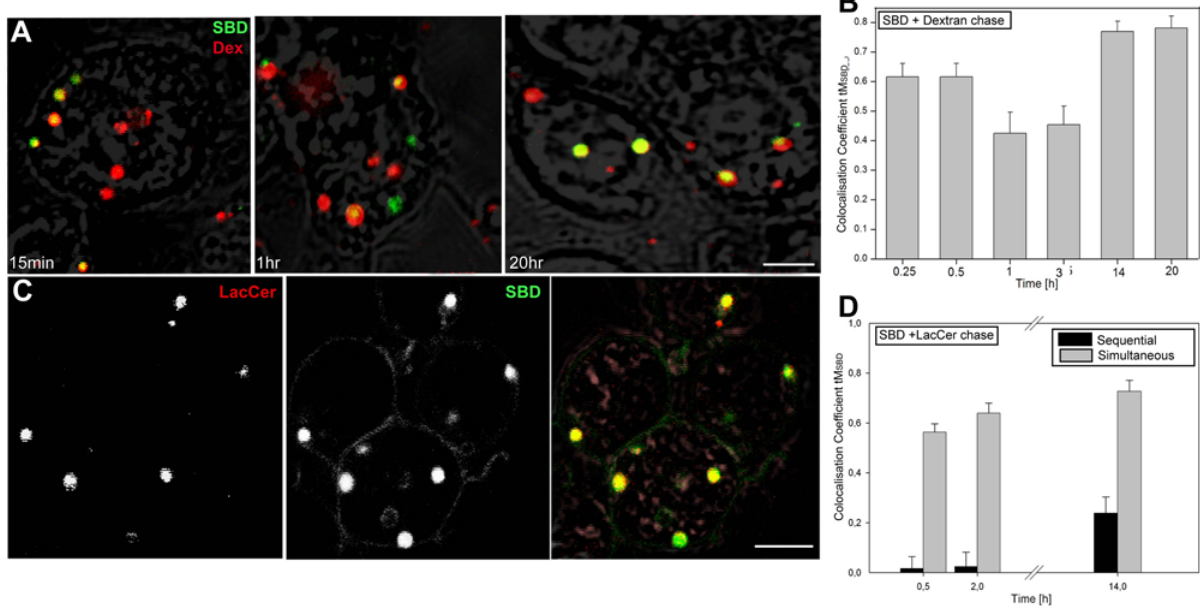
Figure 8. SBD-OG traffics similarly to pulsed Dextran-Alexa670 and lactosyl-ceramide when both labels are present simultaneously at the plasma membrane. A, B. SBD-OG follows a similar pathway to Dextran-Alexa670 (shown after 15 9 , 1 h, and 20 h), but appears to diverge transiently in post-sorting late endosomes between , 60 min and 3 h (see movie S3). Cells were incubated first with SBD-OG at 5 uM in HBSS for 15 min at 25 u C, washed once, and incubated in Dextran-Alexa670 at 0.5 mg/ml in HBSS for 5 min, washed, chased in HBSS, then imaged at the time- points given in the graph (B). C, D. BODIPY-lac-cer (red) shows nearly complete colocalization with SBD-OG (green) when incubated simultaneously on c6 neurons (gray bars; see Methods). Sequential incubation (black bars) leads to much lower colocalization scores. Even after 14 h, colocalization levels never approach those attained with simultaneous incubation, indicating an altered trafficking route taken by at least one of the two labels. For simultaneous SBD/lactosyl-Ceramide labellings, cells were incubated with lactosyl-Ceramide (5 mM at 4 u C for 30 min, washed once, incubated with SBD-OG (25 u C as in A), chased in HBSS, and imaged at the time-points given in graph (D). For sequential labellings, cells were incubated with BODIPY- lac-cer at 25 u C, washed several times in warmed HBSS to allow uptake, then incubated with the second label (SBD-OG) at physiological temperature (concentrations as above), washed in HBSS, and chased in growth medium. Scalebar=5 m m.